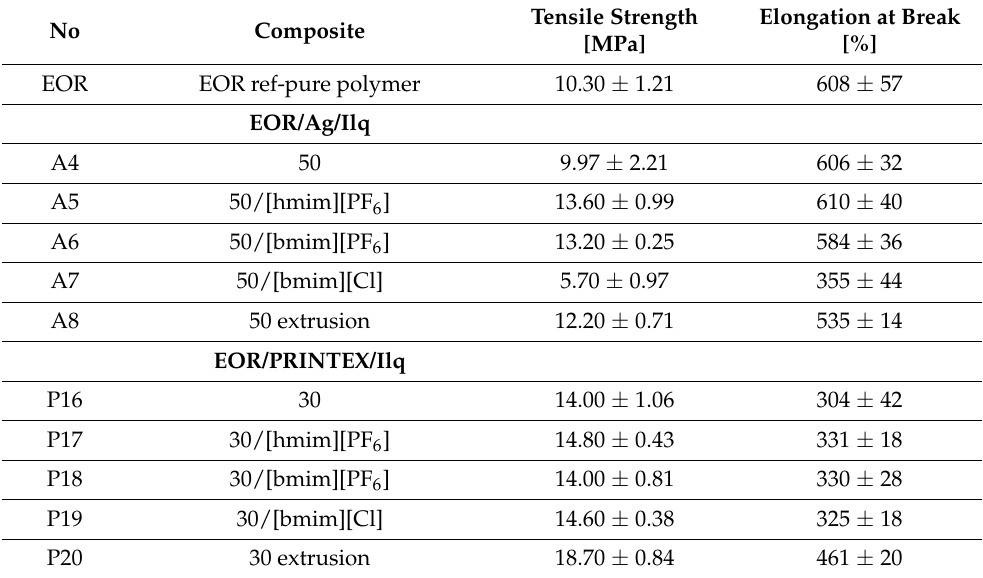
Table 4. The results of measurements of the tensile strength (TS) and elongation at break (Eb) of developed polymer films.